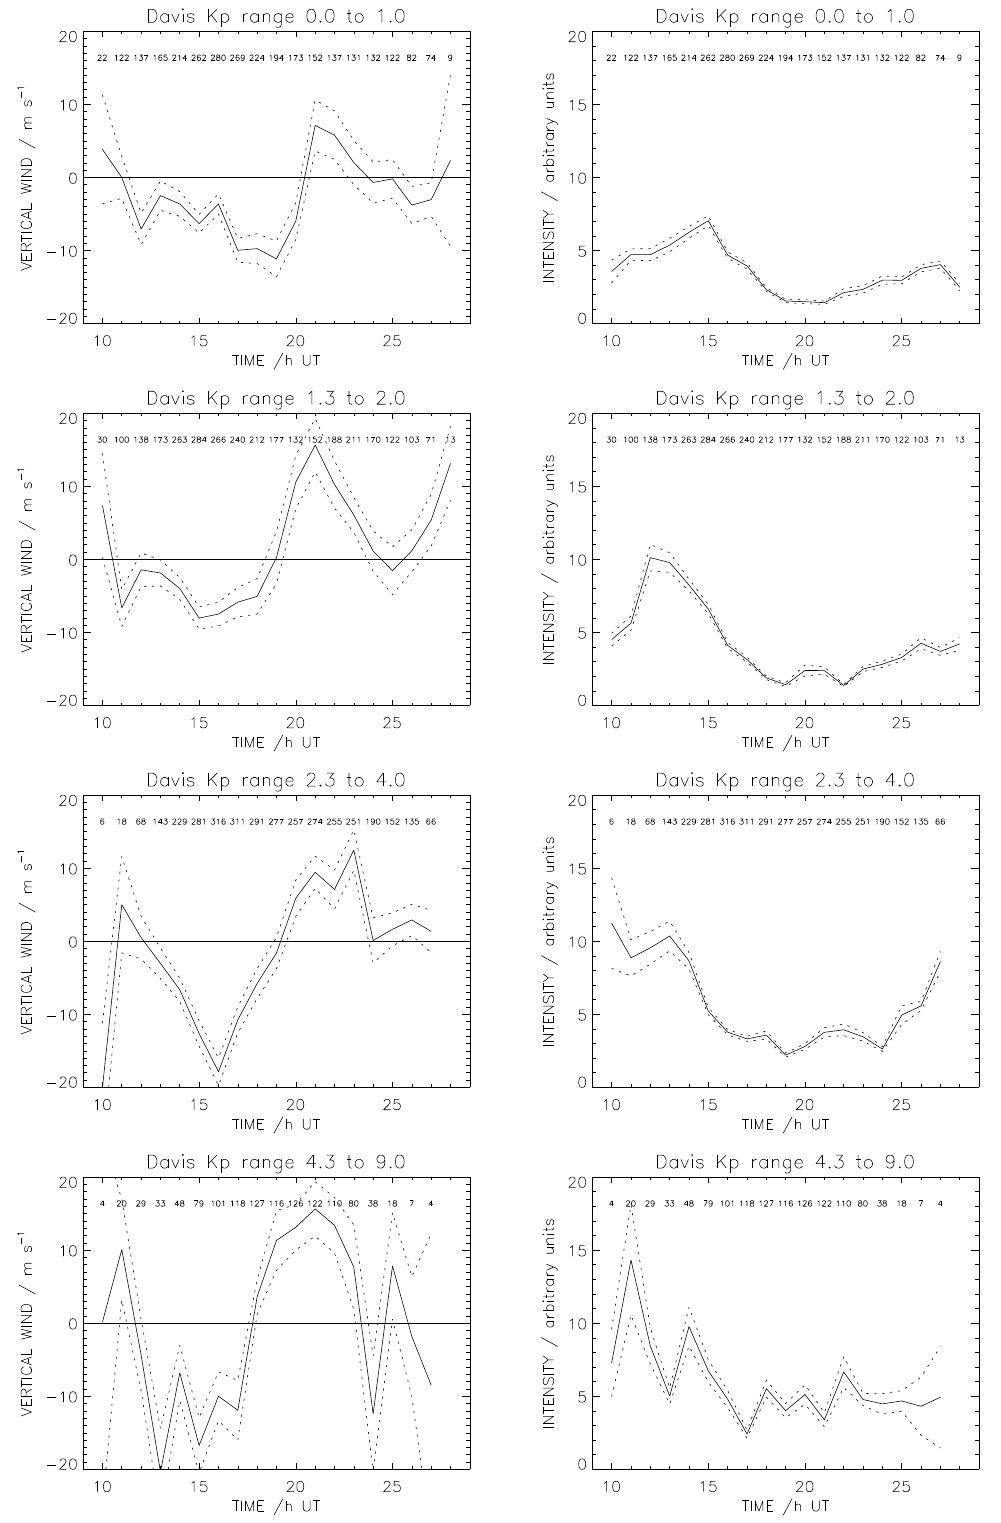
Fig. 5. Davis hourly mean vertical winds (left) and intensity (right) in four K p ranges, 0.0 to 1.0, 1.3 to 2.0, 2.3 to 4.0 and 4.3 to 9.0. The number of points in hourly means are indicated at the top of the plots. Standard errors are indicated by dashed